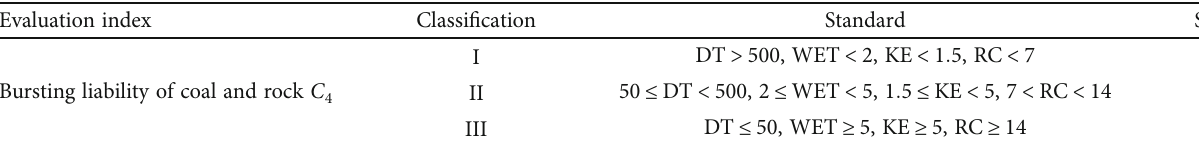
Table 7: Classi fi cation of coal and coal bursting pressuring liability.